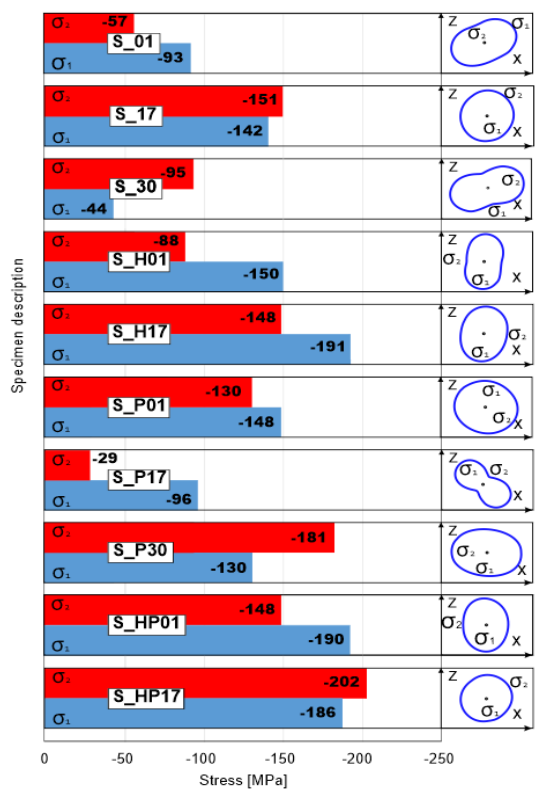
Figure 2. Residual stresses measured in two different directions of the samples after different types of processing (as build, underwent HIP, and precipitation annealed).